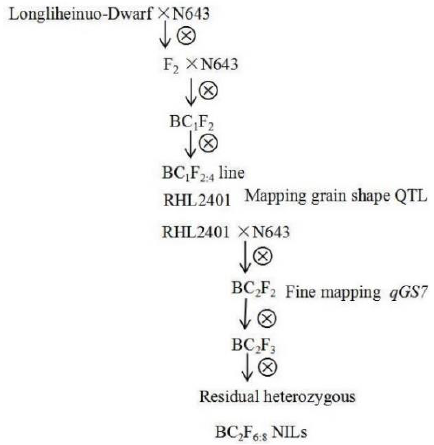
Figure 1. Schematic of the generation of the genetic materials used in this study.